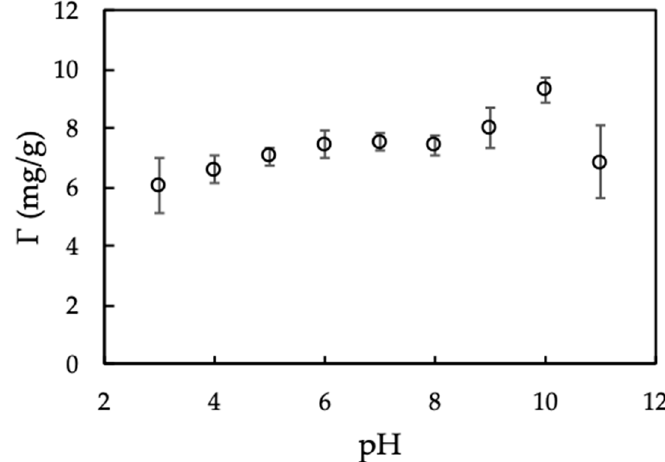
Figure 5. Effect of pH on Moringa seeds protein adsorption onto nanosilica. ( C i (protein) = 100 mg/L, adsorbent dosage 10 mg/mL, 10 mM KCl). Error bars show standard deviations of three replicates.